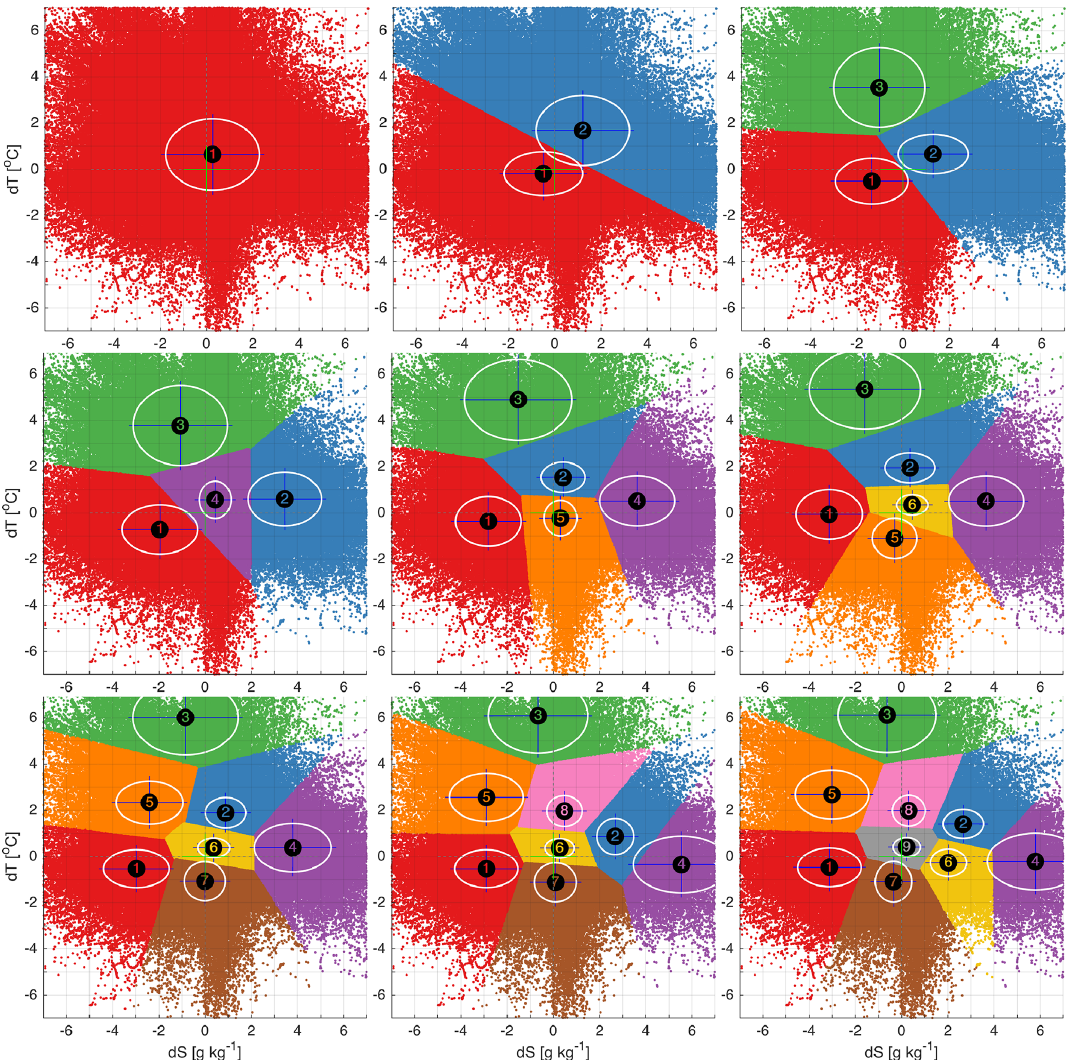
Figure 3. The distribution of clusters in the error space for a different number of predefined clusters, K = 1–9. The numbers of the clusters correspond to the numbers of the clusters in Table 1. The biases are marked with the centre of the ellipsoid and the standard deviations with the major semi-axes. The error space has been zoomed in for better visualization of the clusters. The full range of error space and distribution of the clusters is shown in Fig. A1 in Appendix